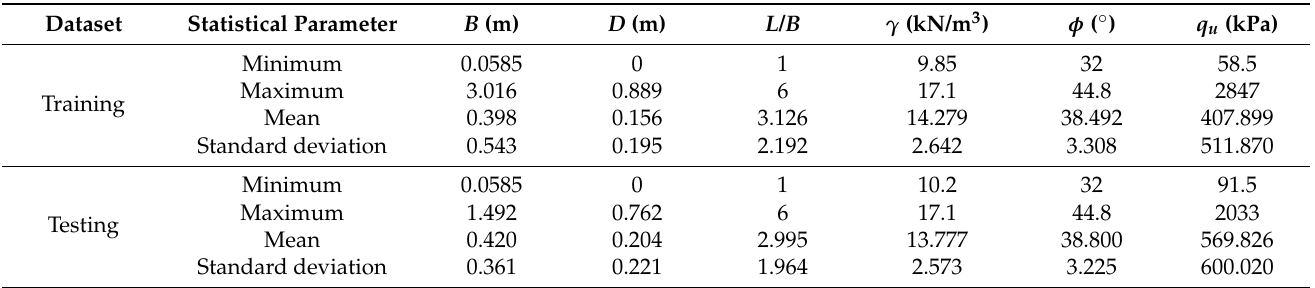
Table 2. Statistical aspects of the dataset.